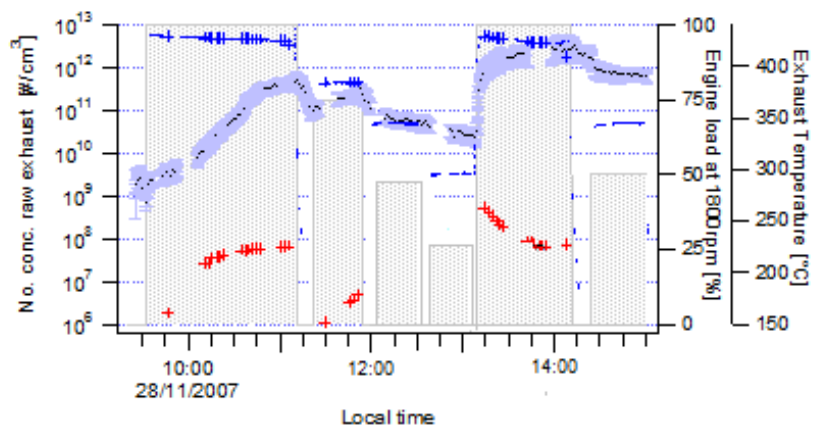
Figure 2. Time series of the concentrations of GSA (black curve) along with standard deviations (light blue shaded area), and particles larger than 3nm (red crosses) in the raw exhaust as a function of engine load (dotted grey bars) at 1800rpm. Also shown is the exhaust temperature (blue